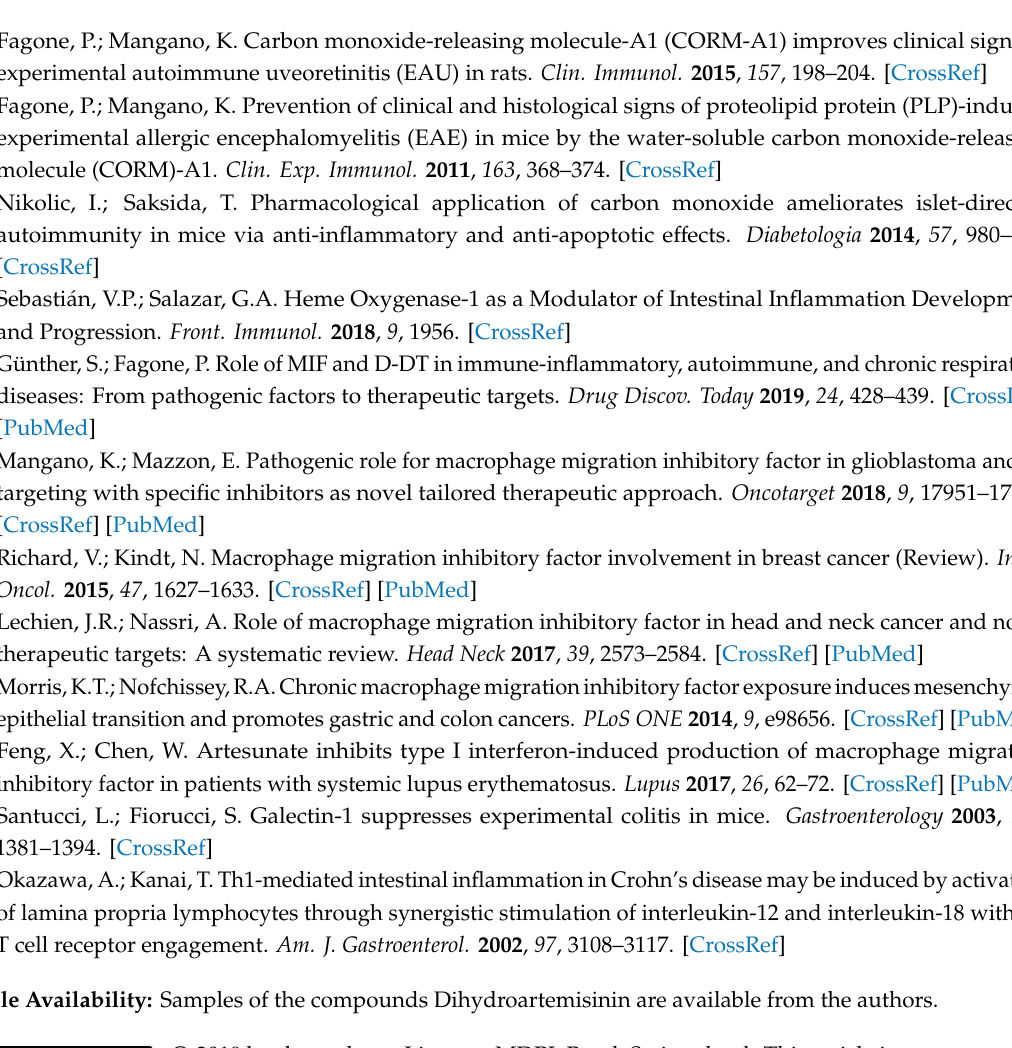
Sample Availability: Samples of the compounds Dihydroartemisinin are available from the